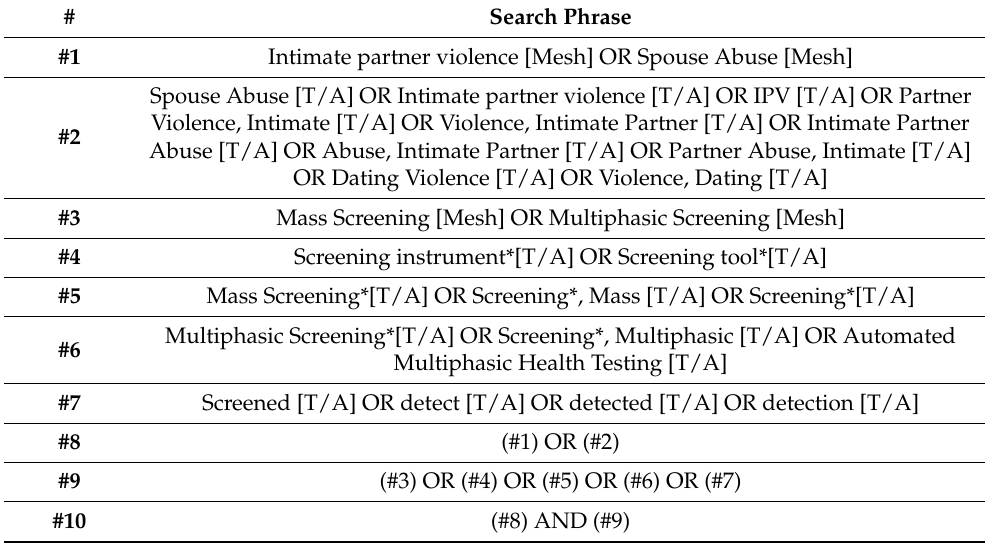
Table 1. An example of the search strategies used in